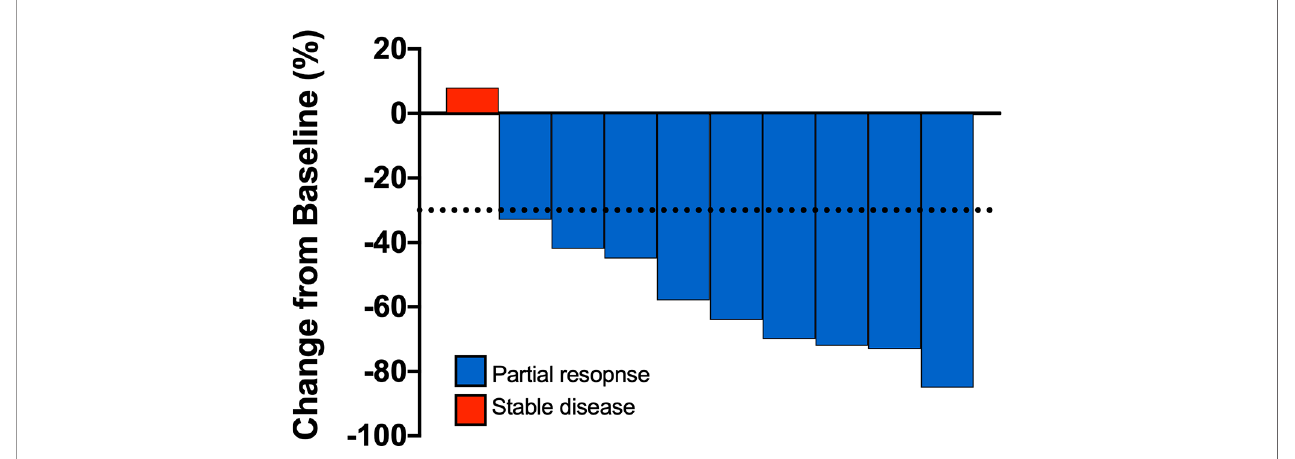
FIGURE 1 | Waterfall plots are shown summarizing the best percentage change in target lesions. Each bar represents a